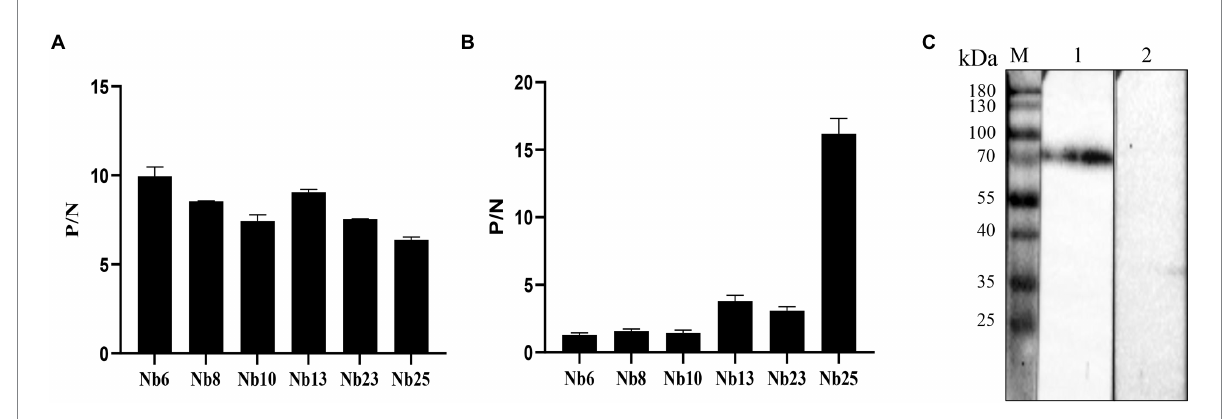
FIGURE 4 Specificity and affinity of nanobodies with ASFV p72 protein. (A) The affinity of nanobodies with recombinant p72 protein analyzed by an indirect ELISA. ASFV-p72 protein was incubated with solid phase coated nanobodies. The ASFV-positive serum and HRP-conjugated rabbit anti-pig antibody were then added. The ASFV-negative serum was used as negative control. The P/N value is the average of two wells. Error bars represent ±SD. (B) The affinity of nanobodies with native p72 protein of ASFV analyzed by a sandwich ELISA. The polyclonal antibody against ASFV was coated on the microtiter plate. The diluted virus stock was added to each well. The nanobody was then added, and PBS was used as negative control. The P/N value is the average of two wells. Error bars represent ±SD. (C) The specificity of Nb25 analyzed by Western blot. The p72 protein in PVDF membrane was detected by Nb25 and HRP-conjugated rabbit anti-His IgG. M: protein molecular marker; lane 1: PAM cells inoculated with ASFV; lane 2: Negative